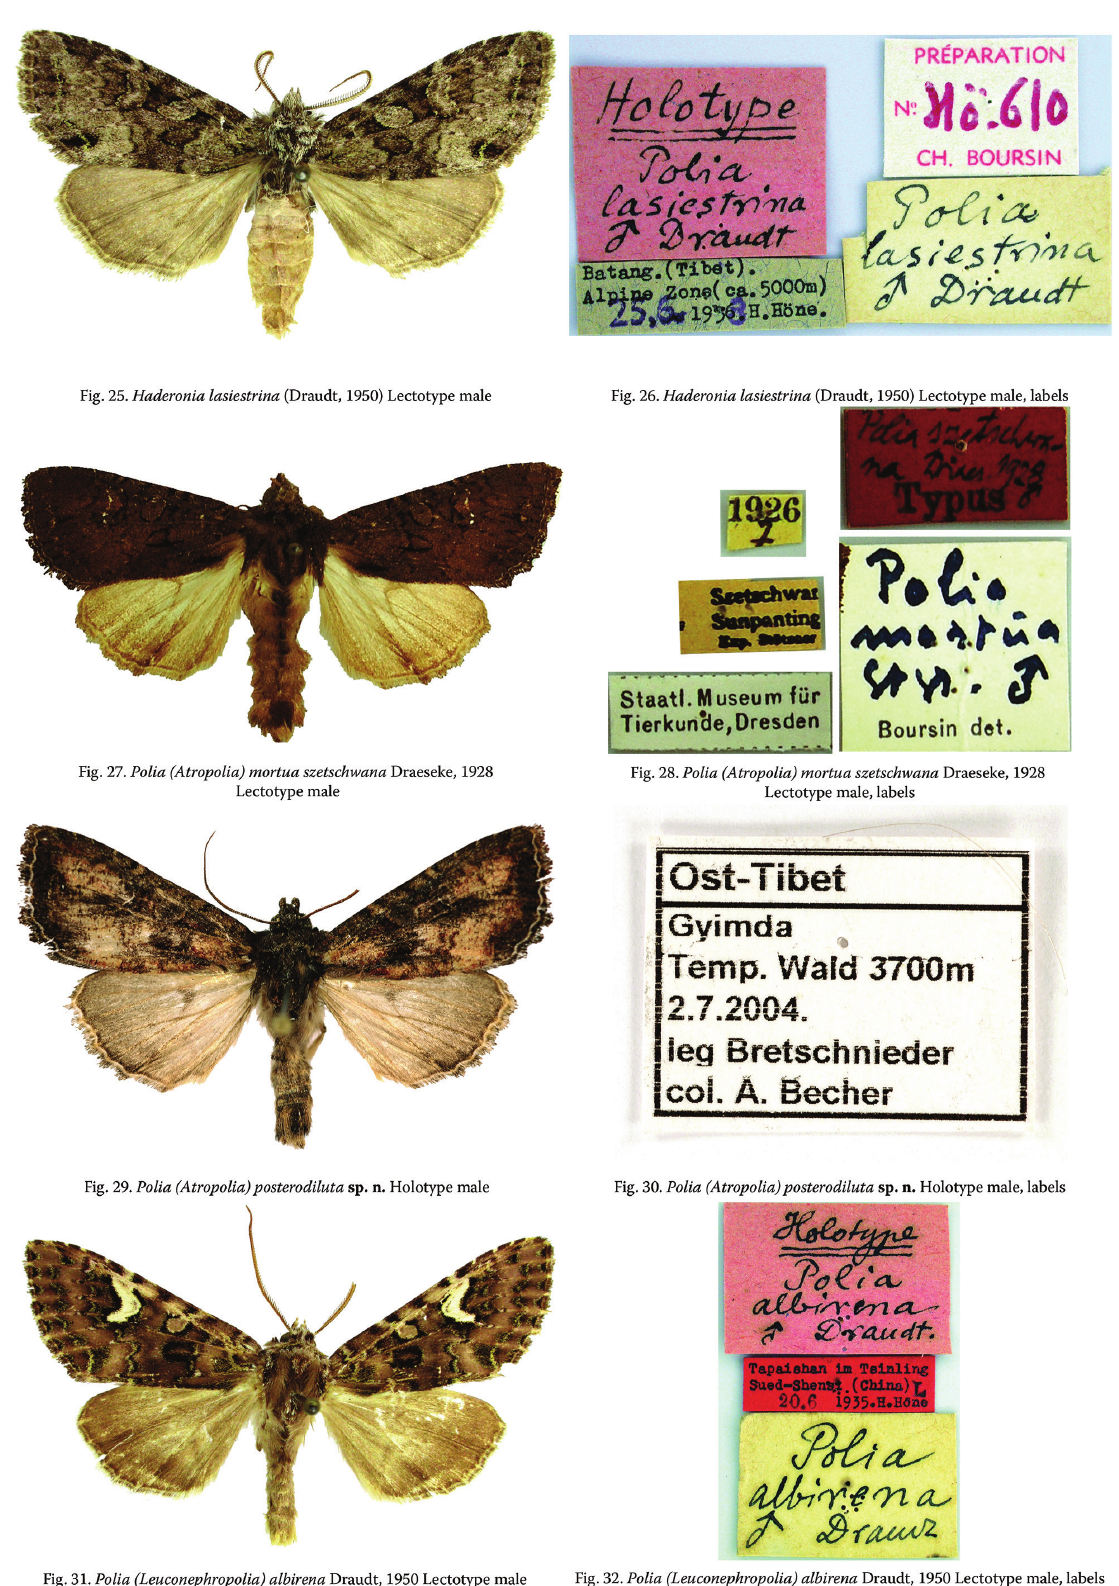
Figure 25–32 . 25. Haderonia lasiestrina (Draudt, 1950) Lectotype male. 26. Haderonia lasiestrina (Draudt, 1950) Lectotype male, labels. 27. Polia ( Atropolia ) mortua szetschwana Draeseke, 1928 Lectotype male. 28. Polia ( Atropolia ) mortua szetschwana Draeseke, 1928 Lectotype male, labels. 29. Polia ( Atropolia ) posterodiluta sp. n. Holotype male. 30. Polia ( Atropolia ) posterodiluta sp. n. Holotype male, labels. 31. Polia ( Leuconephropolia ) albirena Draudt, 1950 Lectotype male. 32. Polia ( Leuconephropolia ) albirena Draudt, 1950 Lectotype male,